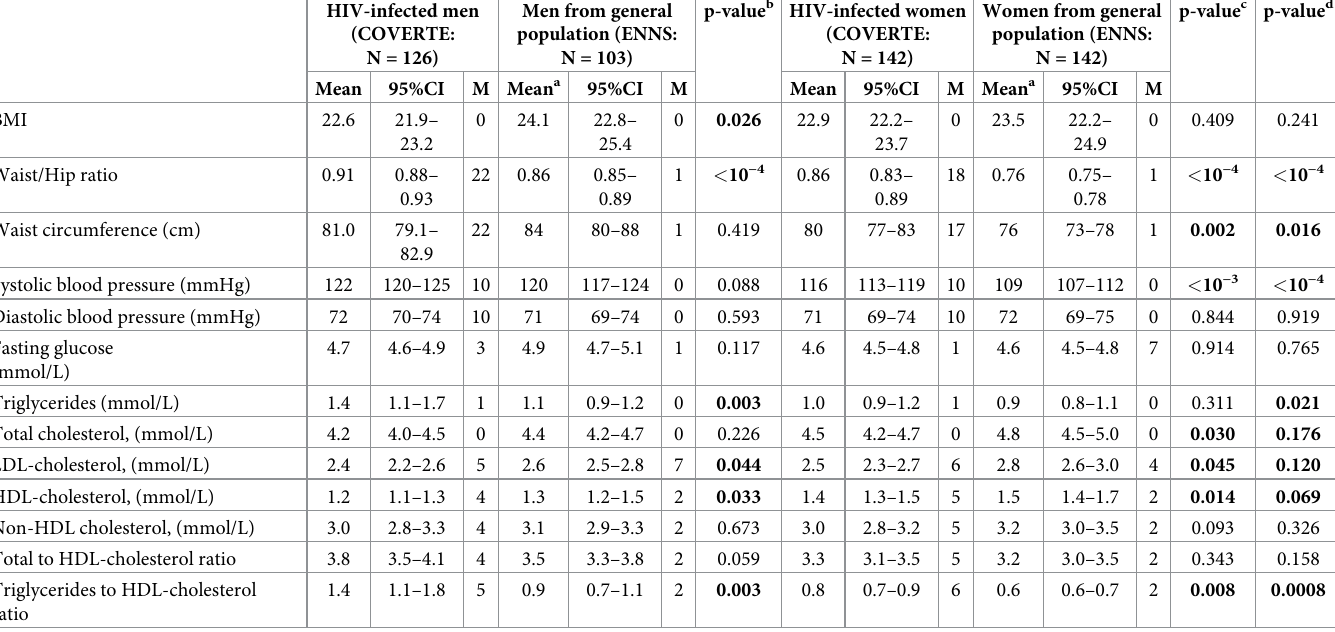
Table 3. Comparison of metabolic parameters of patients infected with HIV since childhood (COVERTE) versus the general population (ENNS), adjusted for being overweight and education level, by linear regression. HIV-infected men